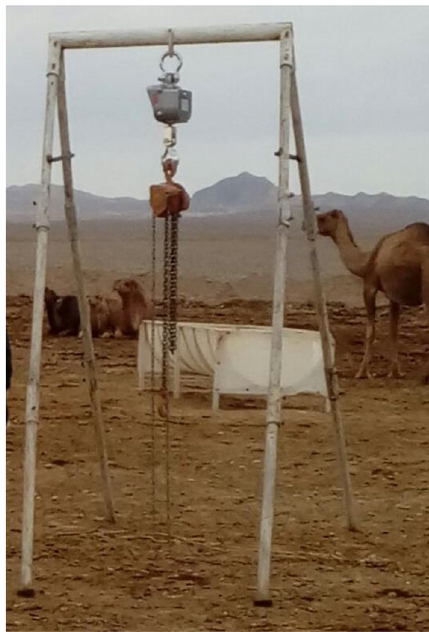
Figure 1. The portable weighting scale (Company: Fuzhou Kejie Intelligent Technology Co.,Ltd. model: OCS-XZ-2, 2000 Weigh Capacity (Kg), Accuracy Class III, + /- 1 division (least count).This were made from 13 pieces of iron, hanging digital scale 2000 kg, and one chain